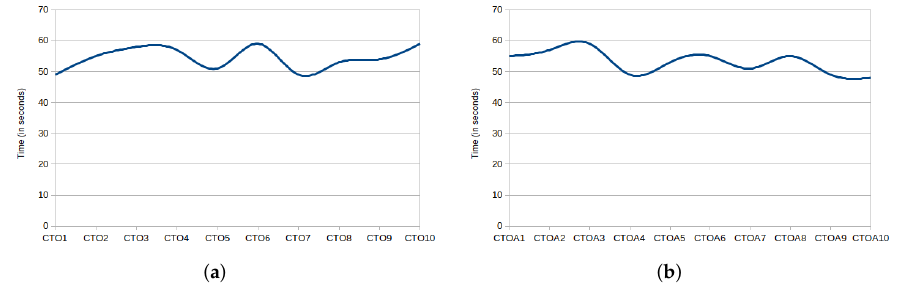
Figure 14. Performance evaluation on contract clause creation and audit. ( a ) Time spent on contractual clause create. ( b ) Time spent on contractual clause audit.